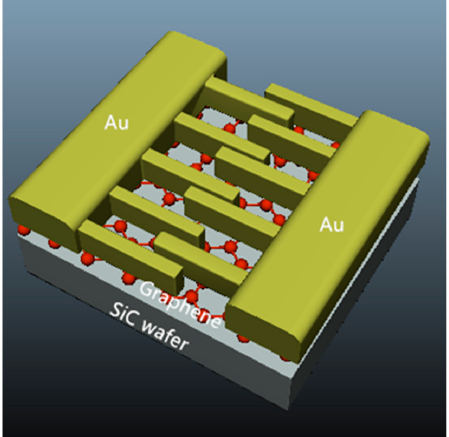
Figure 1. The 3D structure diagram of epitaxial graphene photodetector, the light absorption area is about 1.3 mm 2 while the total size of the device is about 4 mm 2 .